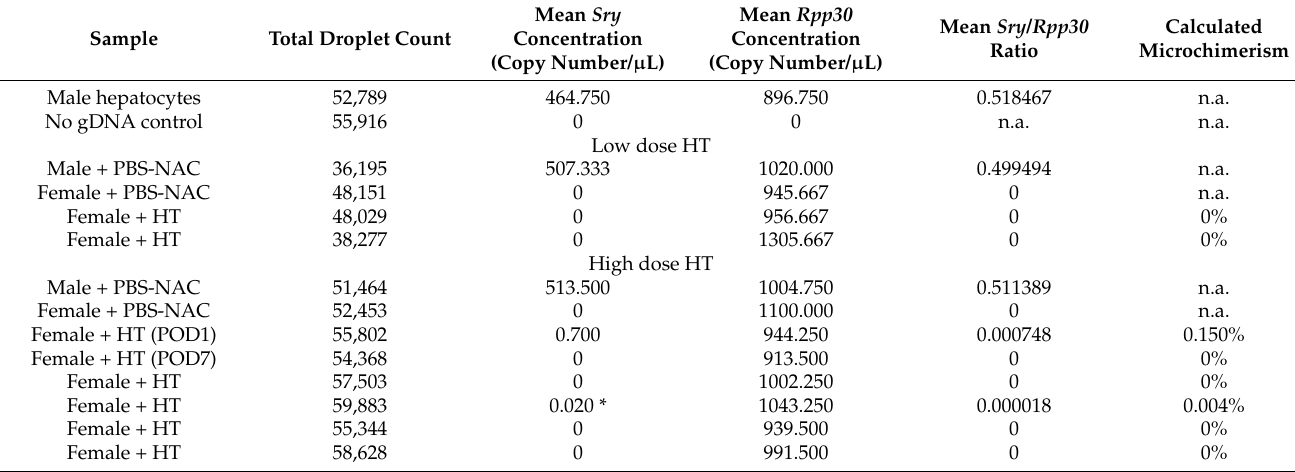
Table 2. Microchimerism evaluation on mice liver in low dose and high dose HT protocols.